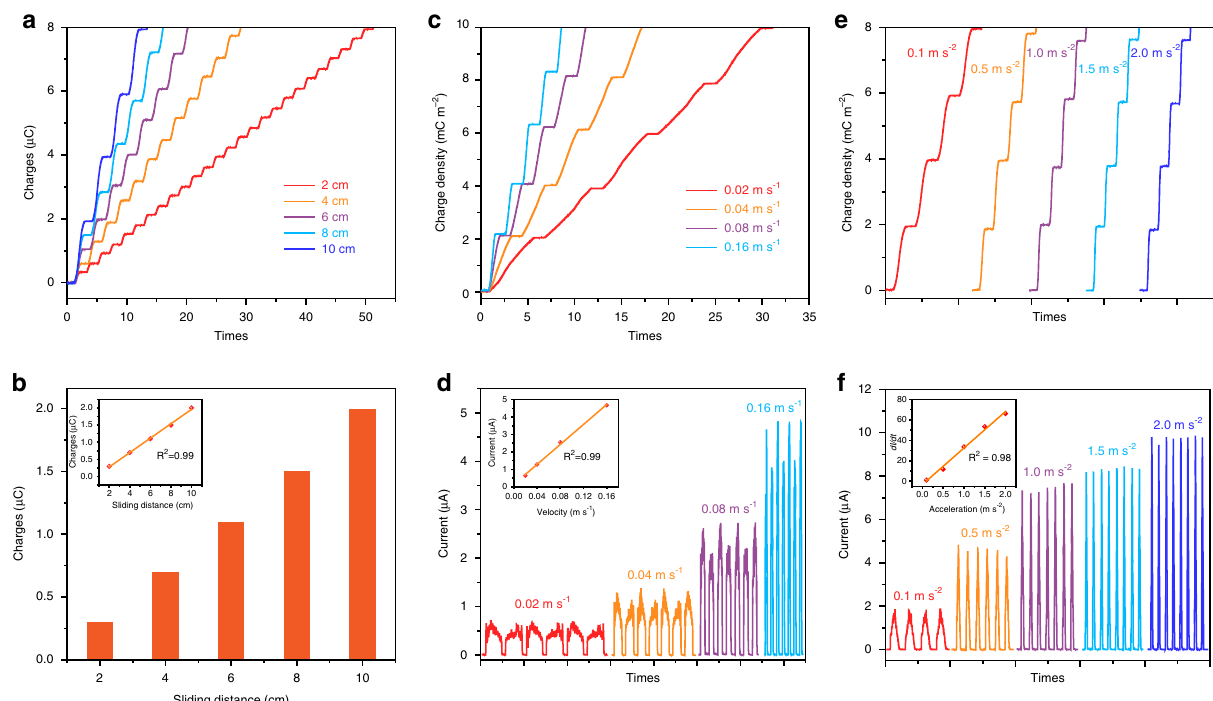
Fig. 3 Performance of MDC-TENG under different vector parameters. a , b The output charges under different sliding distances (the inset is the relationship between output charge and sliding distance). c The charge density and d short-circuit current of MDC-TENG with various velocities (the inset is the relationship between I sc and velocity). e The charge density and f short-circuit current of MDC-TENG with various accelerations (the inset is the relationship between dI / dt and